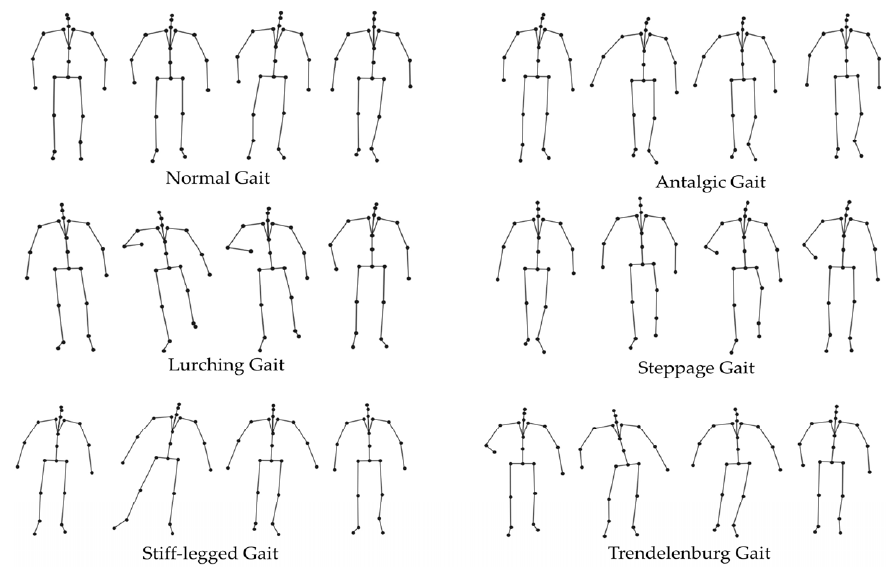
Figure 5. Normal and pathological gaits.